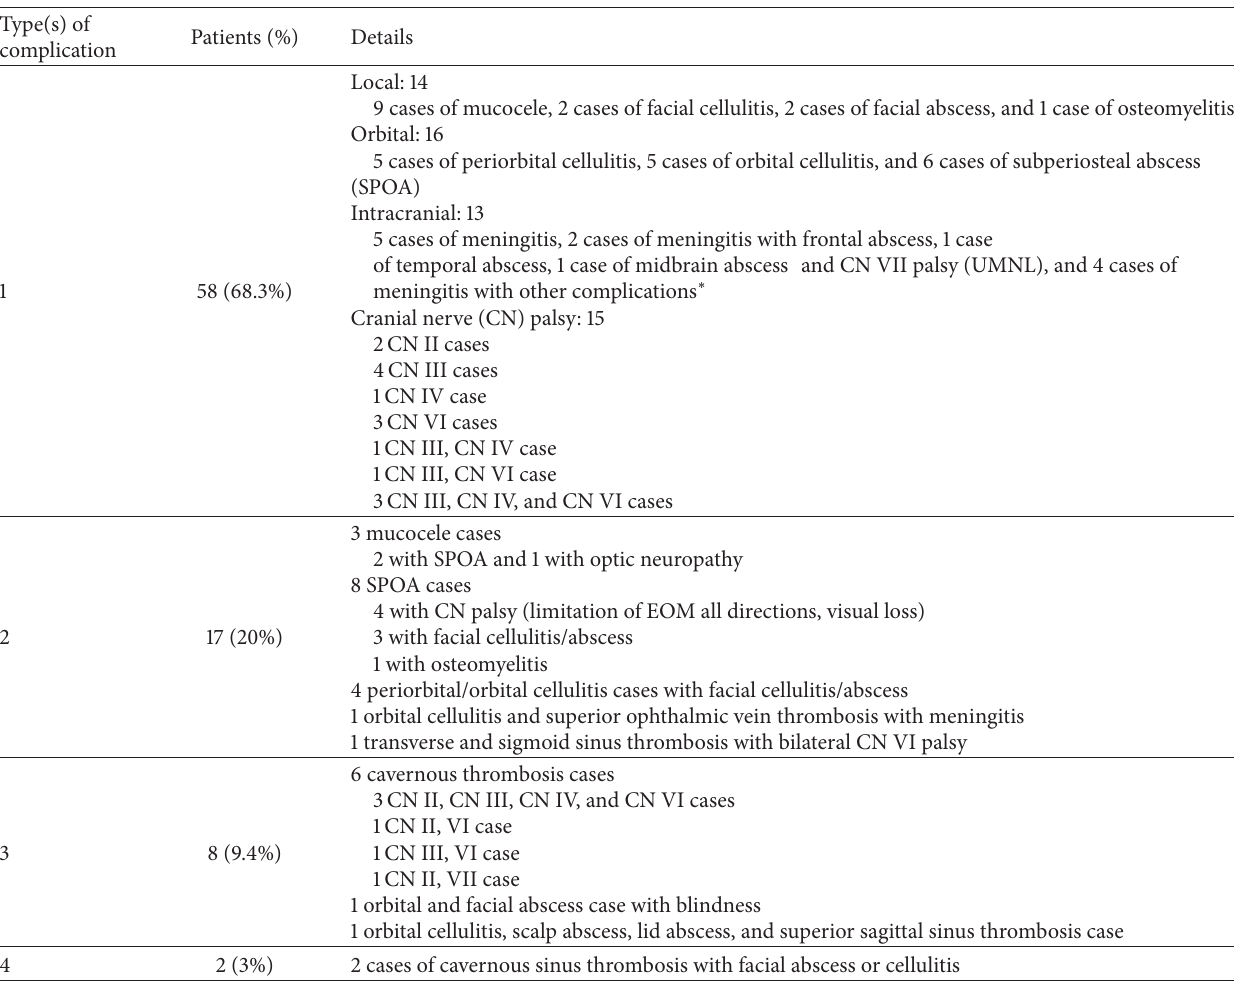
Table 1: Type of complication from sinusitis.